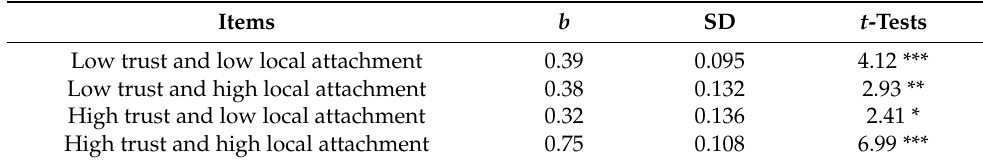
Table 8. Simple slope test.